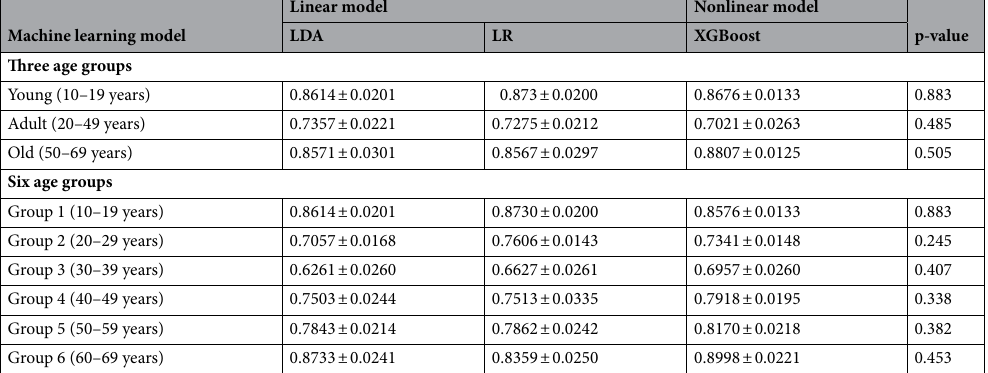
Table 2. Age group differences in the AUC values of LDA, LR, and XGBoost. The AUC values of each machine learning algorithm were obtained, and an ANOVA with a post-hoc analysis was used to determine whether there was a gender difference in these values. P-values of less than 0.05 (*) were considered statistically significant. LDA linear discriminant analysis, LR logistic regression, XGBoost extreme gradient